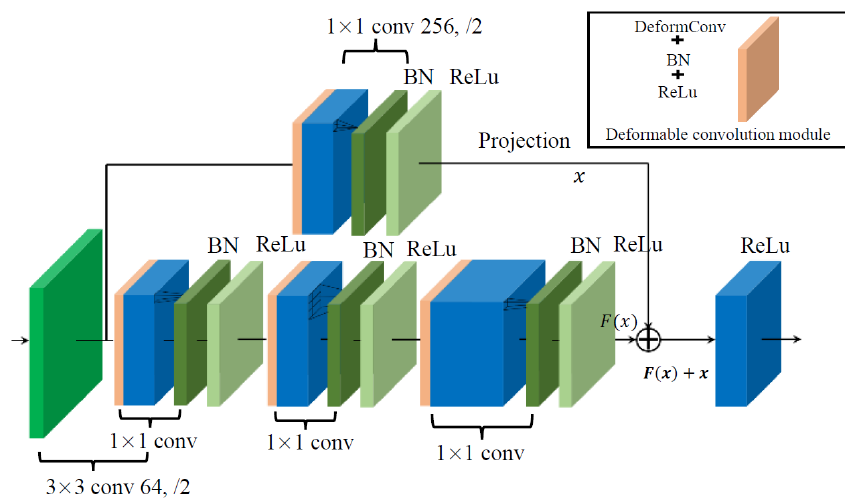
Figure 6. Deformable convolution is added to the residual branch.